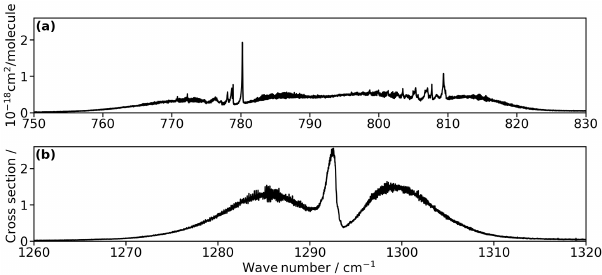
Figure 5. Example of an absorption cross section of ClONO 2 (a) ν 4 and ν 3 and (b) ν 2 bands, measured by Wagner and Birk (2003) in a cuvette at a temperature of 297.4K and pressure of